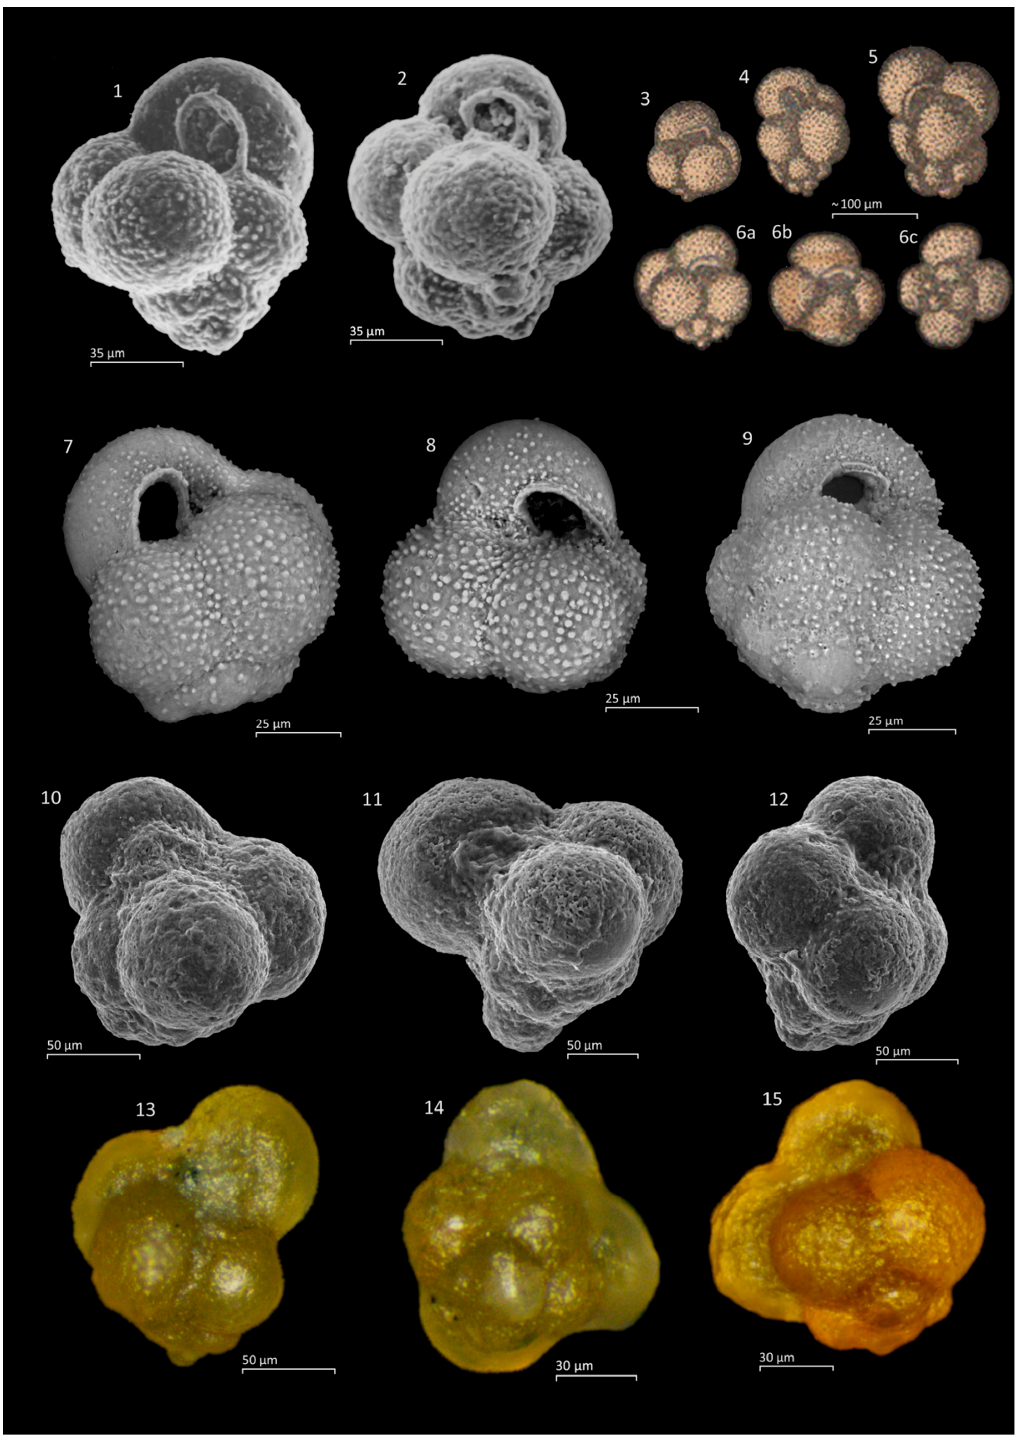
Figure A2. Globuligerina bathoniana (Paszdrowa). Subfigures 1 and 2 , Eider M-75 well, cts. 8260-8290 (cid:48) , Garantella spp. Zone, Bajocian-Bathonian, Grand Banks, Canada. Subfigures 3 – 6 , re-illustration of Bathonian type species drawings provided by Olga Pazdrowa to Felix Gradstein. Specimen height 140–180 µ m. Subfigures 7 – 9 , sample 6, Morrisi Zone, Middle Bathonian, Gnaszyn, Poland. Globuligerina dagestanica (Morozova). Subfigures 10 – 15 , topotype specimens from samples 8 and 9, Khouroukra section, Late Bajocian,